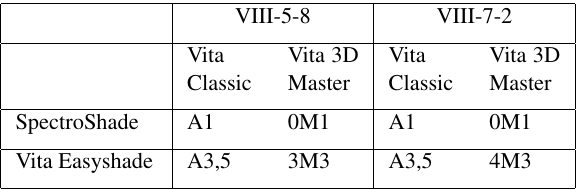
Table 1. Shade matching results by two